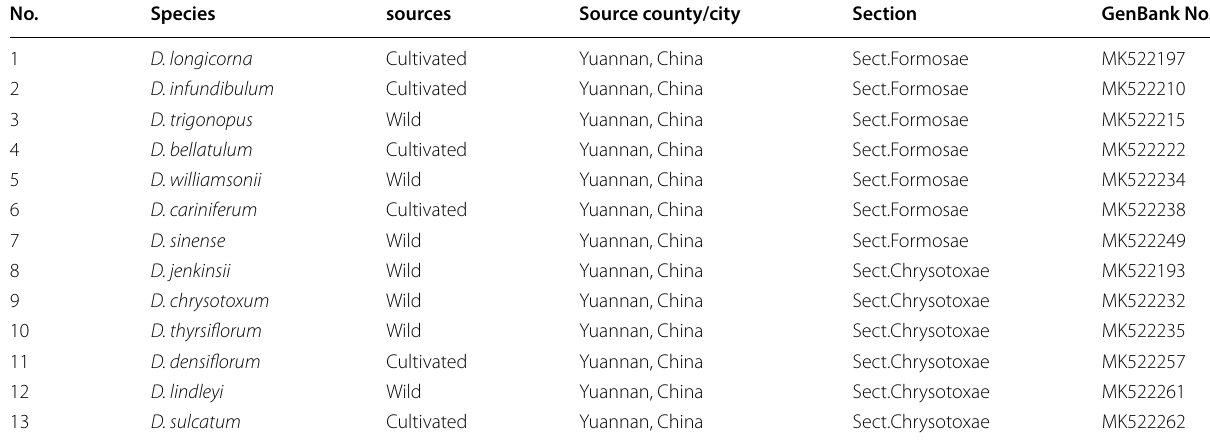
Table 1 Dendrobium specie plants used in the study